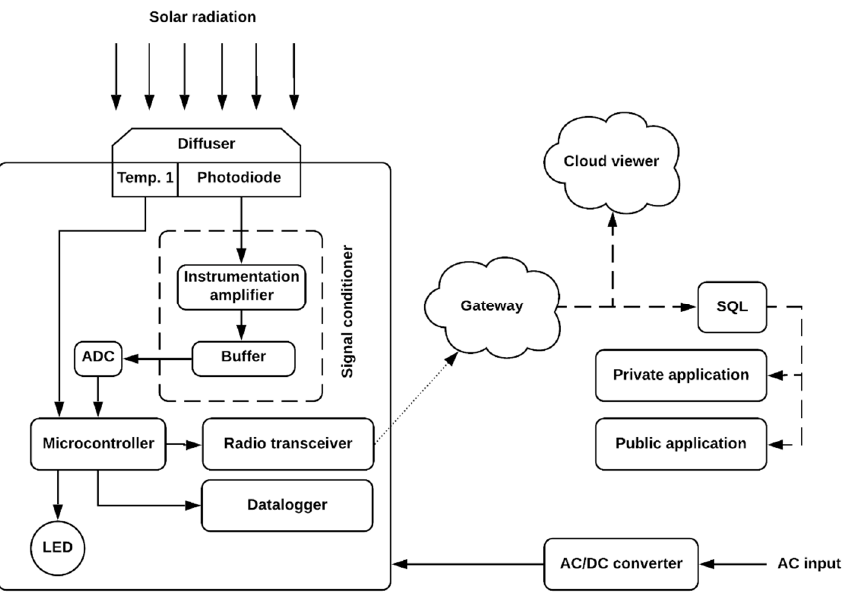
Figure 2. Block diagram of the wireless system for monitoring solar irradiation at the surface.